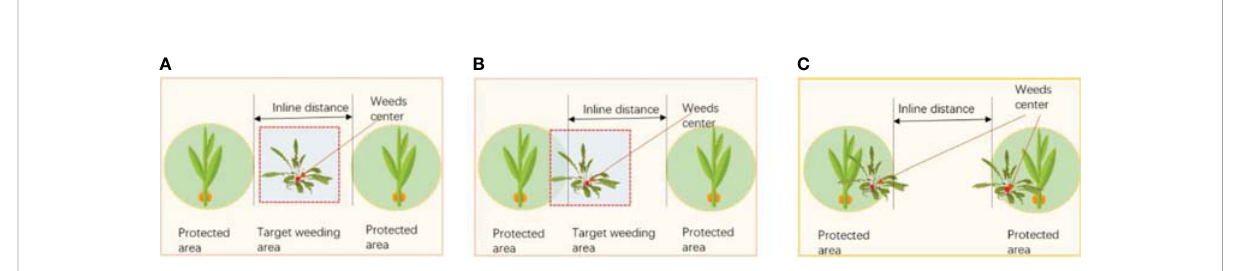
FIGURE 8 Determine the weeding strategy, (A) complete weeding (B) partial weeding (C) no